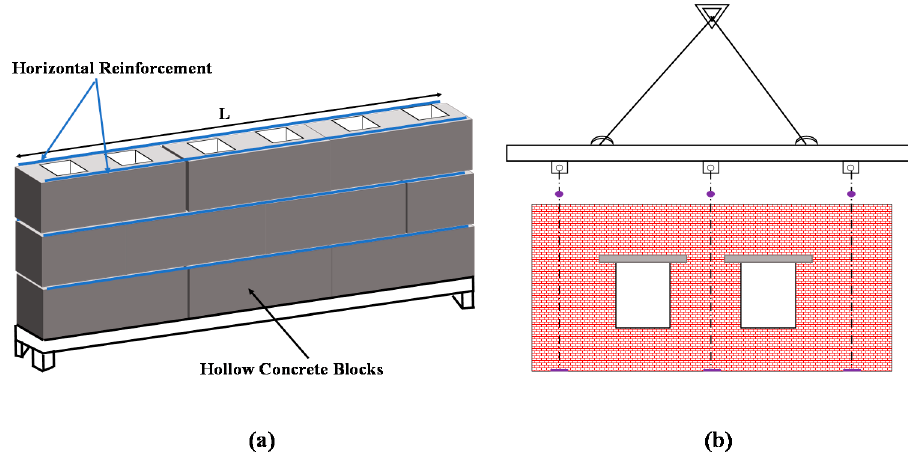
Figure 3. Prefabricated RM system developed by Muirhead et al. [46] ( a ) Sectional view of the prefabricated wall and ( b ) lifting position of the walls.